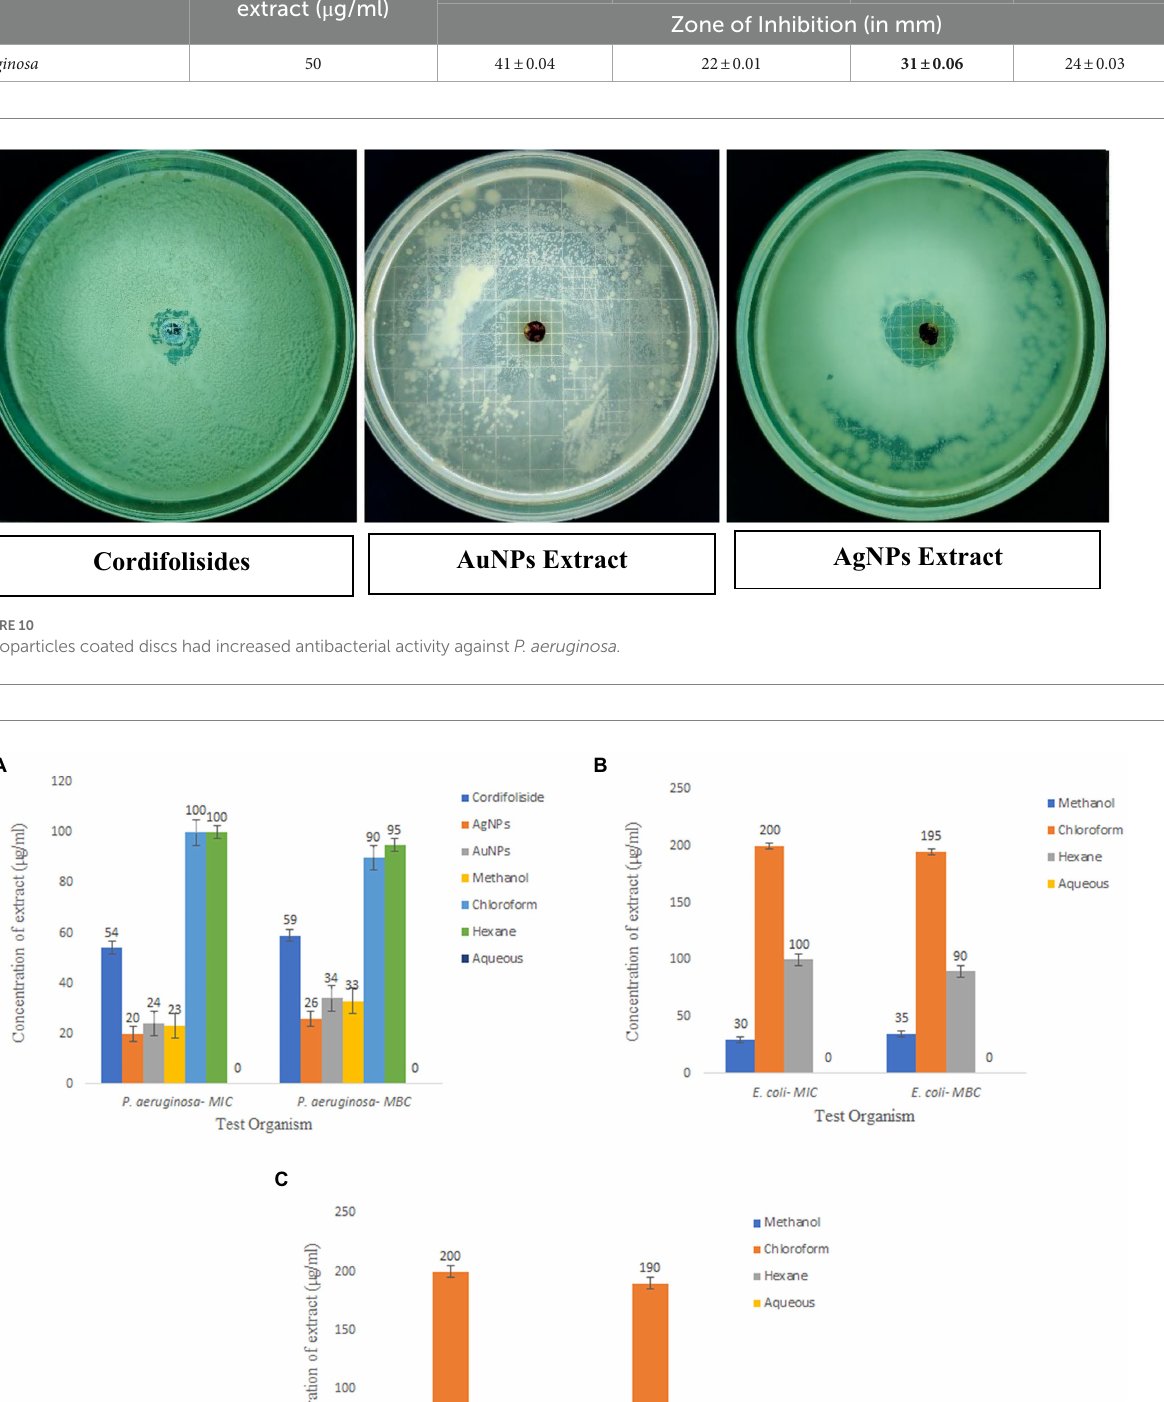
TABLE 5 Enhanced antibacterial activity of AgNPs and AuNPs against pathogenic bacteria P. aeruginosa. Microorganism Concentration of extract ( μ g/ml)